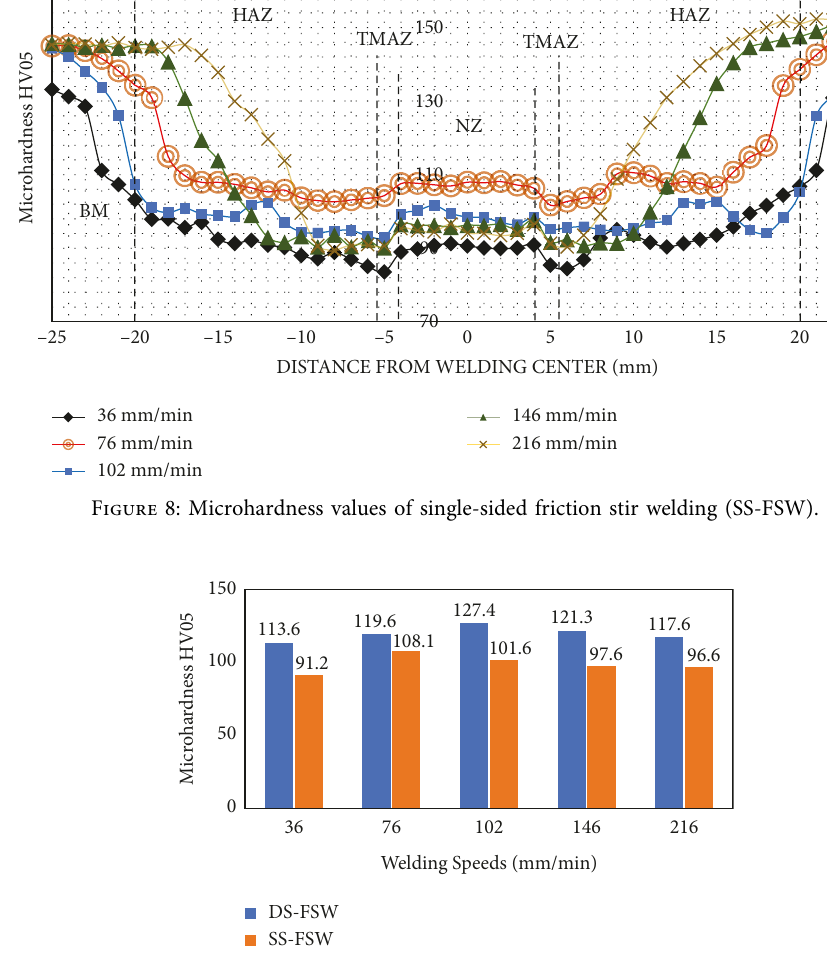
Figure 9: Microhardness value of stir zone for various welding speeds.